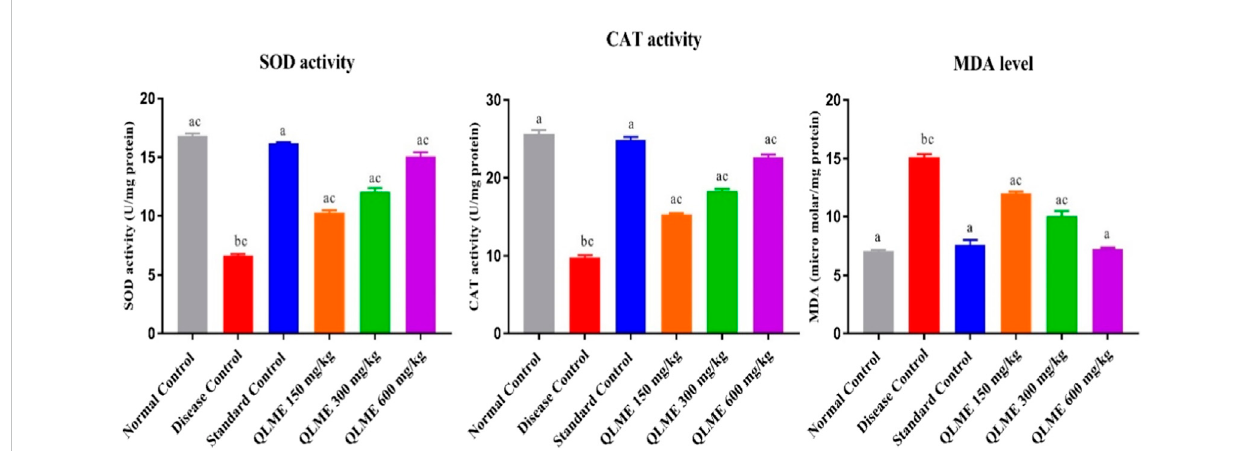
Effectsof Quercusleucotrichophora extractonoxidativestressbiomarkersinCFA-inducedarthriticrats.Resultsareexpressedasmean±S.D(n=6) andone-wayANOVAfollowedbyTukey ’ stest.a:diseasecontrol;b:normalcontrol;andc:standardcontrol. p < 0.05incontrasttoDC,NC,andstandard control.